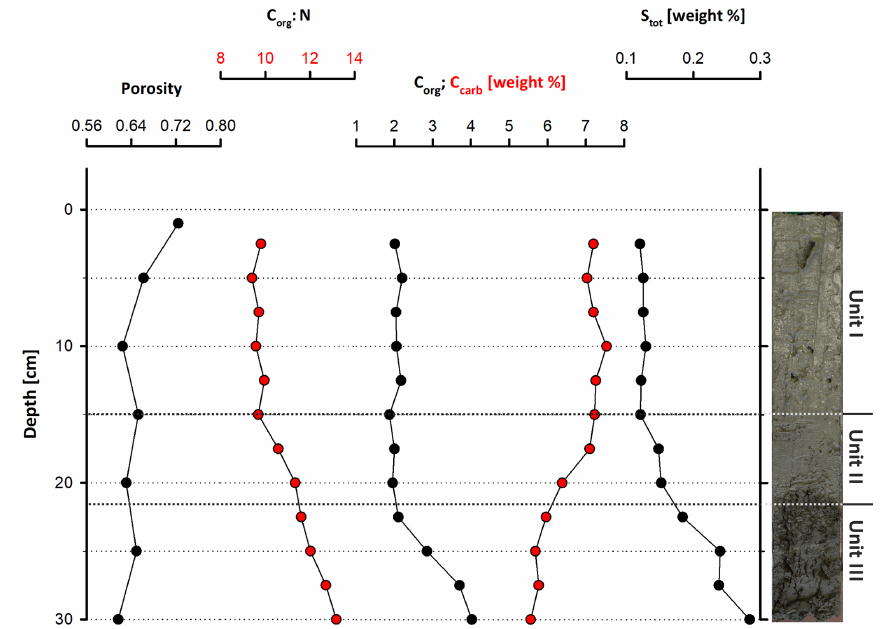
Figure 3. Geochemical parameters through Core LN-K04, showing an increasing amount of organic carbon and total sulfur and a decreasing porosity with